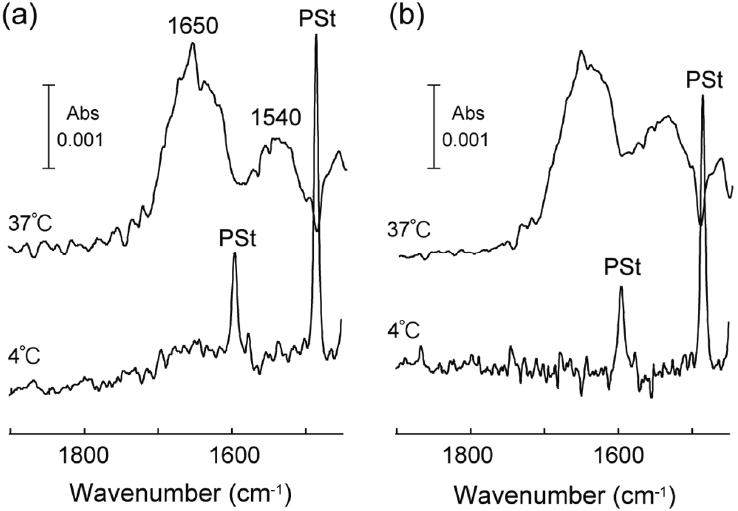
Figure 4. ATR-FTIR spectra of the self-assembled molecular layers of ( a ) RGDS-ELP and ( b ) RGDS- deg -ELP on PSt-dish prepared at 37 °C and 4